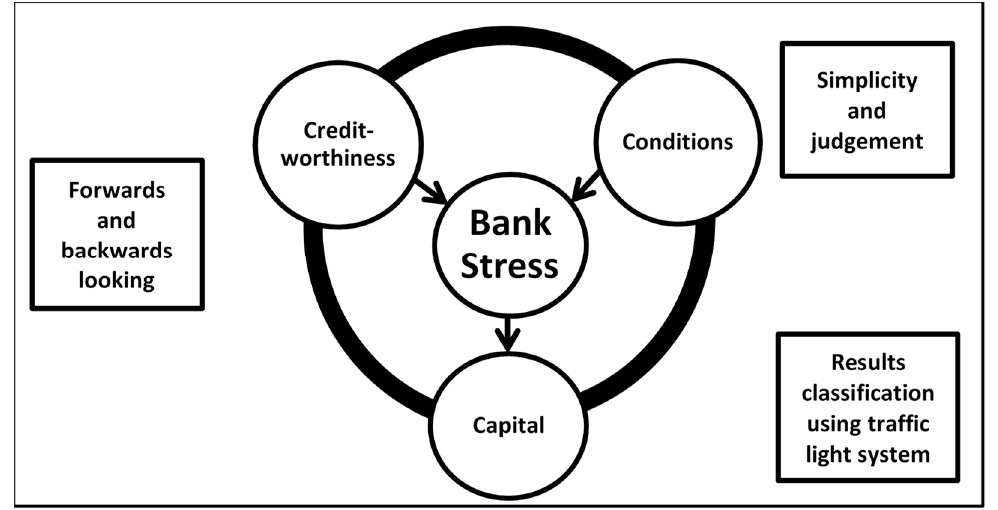
Figure 1. Comprehensive Stability Indicator ( CSI ) Model.